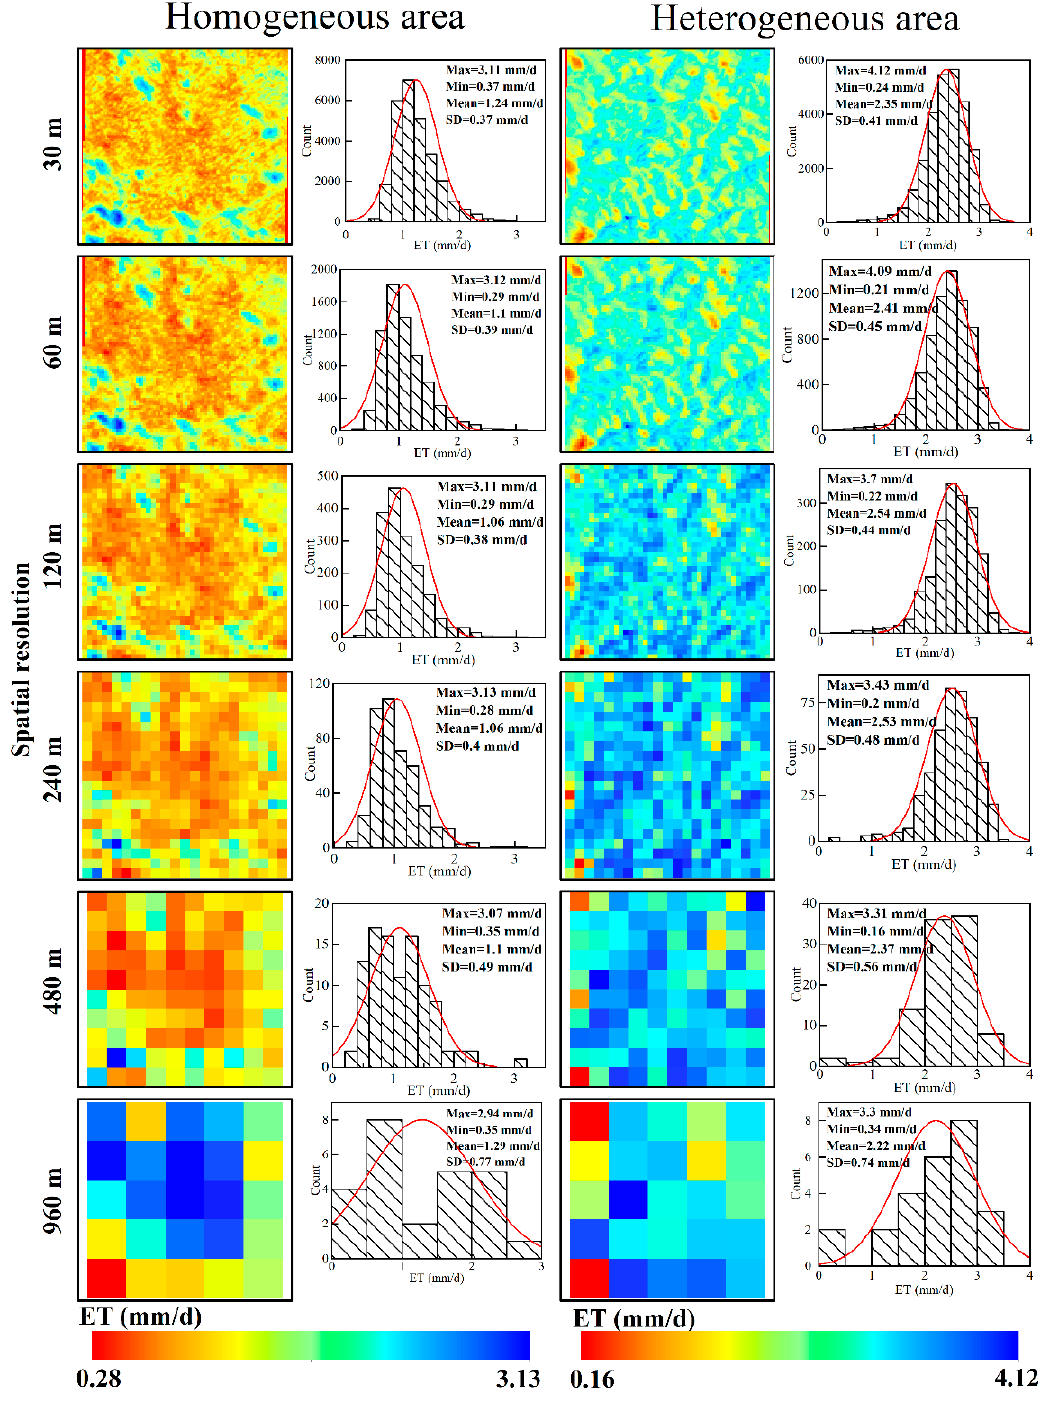
Figure 10. Spatial and frequency distribution of the simulated ET over homogeneous and heterogeneous areas at different spatial resolutions.